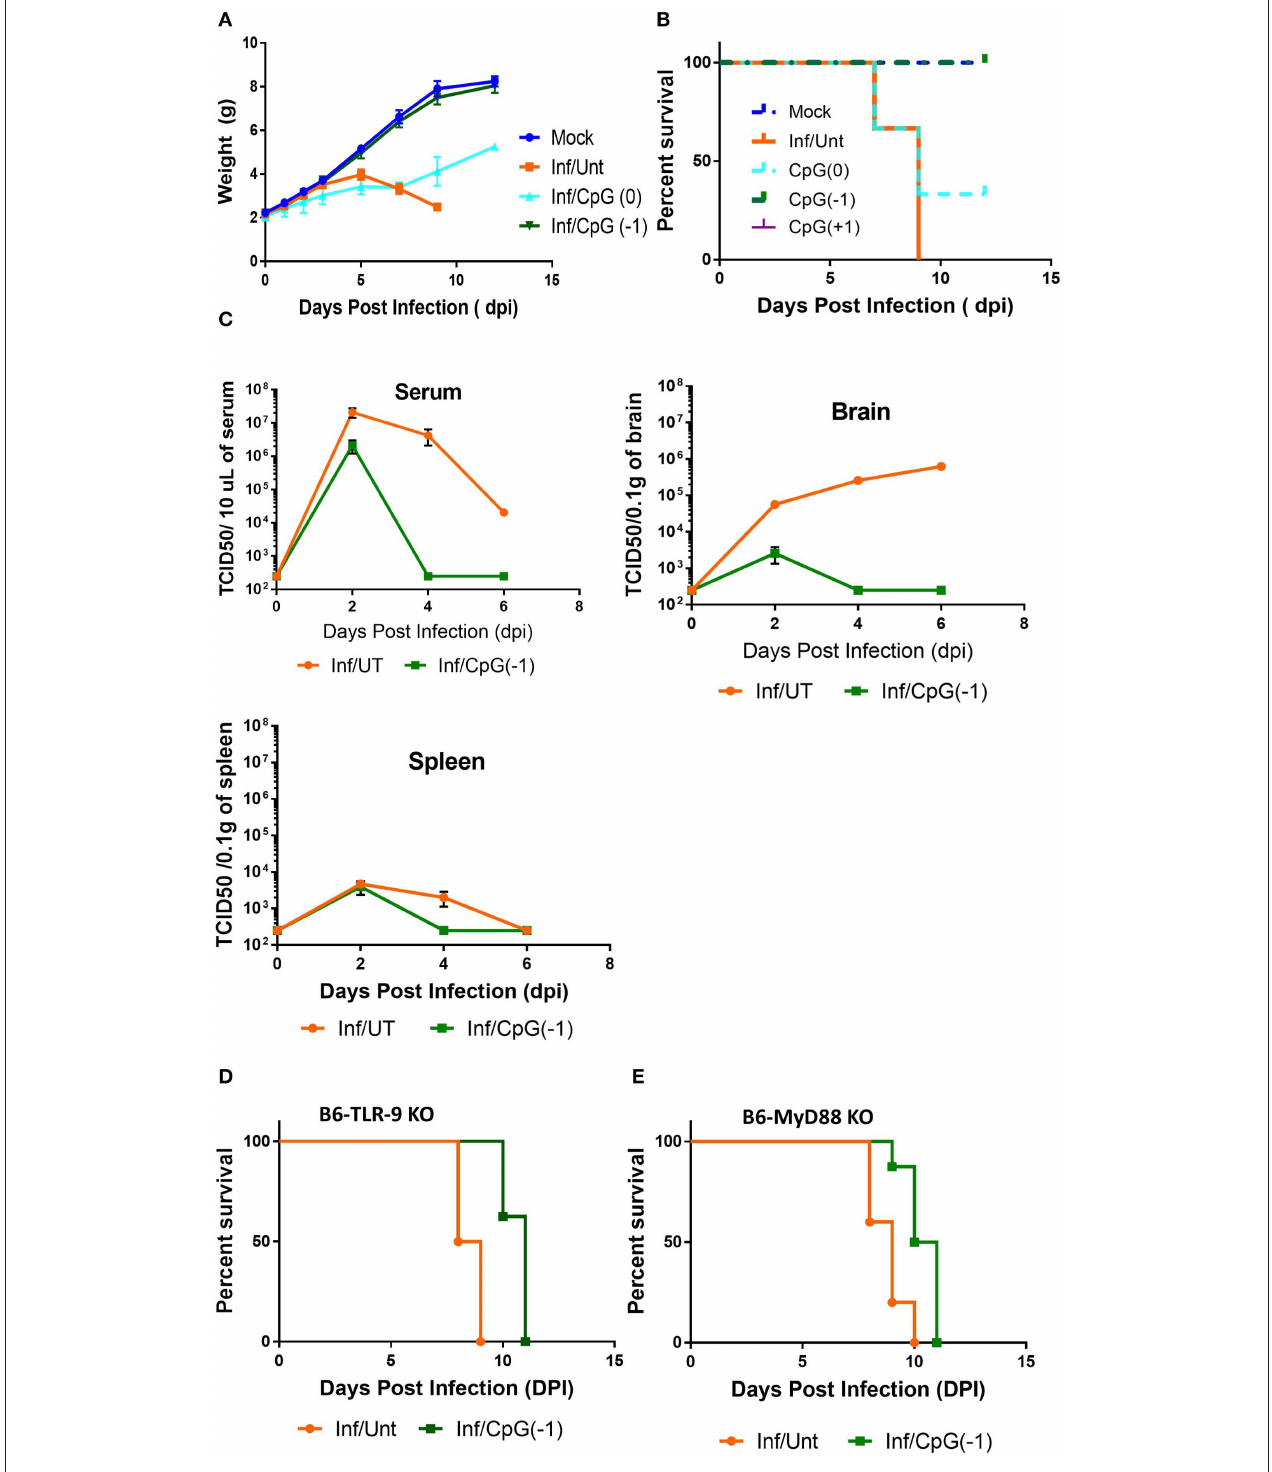
FIGURE 4 | CpG ODN treatment rescues B6-WT mice from lethal SINV infection. B6-WT mice were treated with CpG ODN (IP, 50 µ g) on CpG (-1)/(P2) or CpG (0)/(P3) and infected with 25 PFU SINV on P3. Weight gain (A) and survival (B) was monitored every other day. (C) Viral loads in blood, spleen and brain were obtained from perfused animals at 2, 4, and 6 dpi. Stacked two-way RM ANOVA showed viral titers are significantly different between CpG ODN treated and untreated mice in the serum and brain ( p < 0.001). Survival of (D) B6-TLR-9 KO and (E) B6-MyD 88 KO mice treated with CpG ODN (IP, 50 µ g) on P2 and infected with 25 PFU SINV on P3. Age-matched untreated mice served as